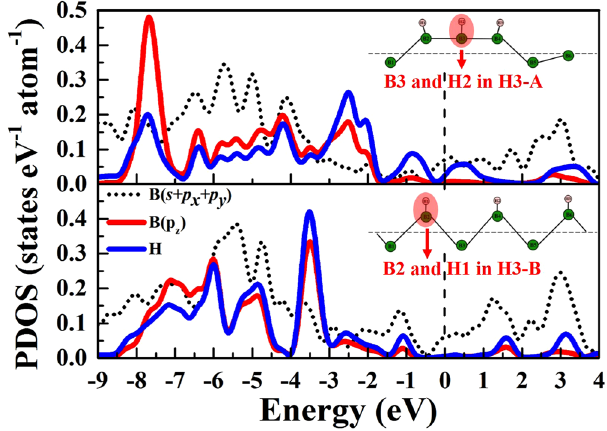
Figure 2. Partial density of states of B atoms and H atoms in three H atoms adsorbed